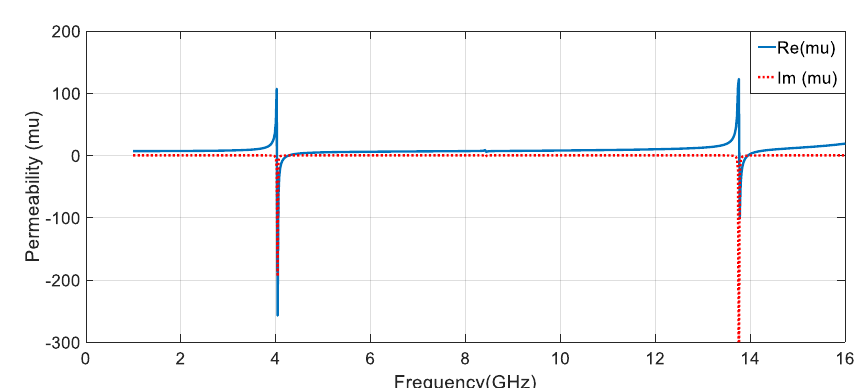
Figure 13. S 11 and S 21 for circular SRR.